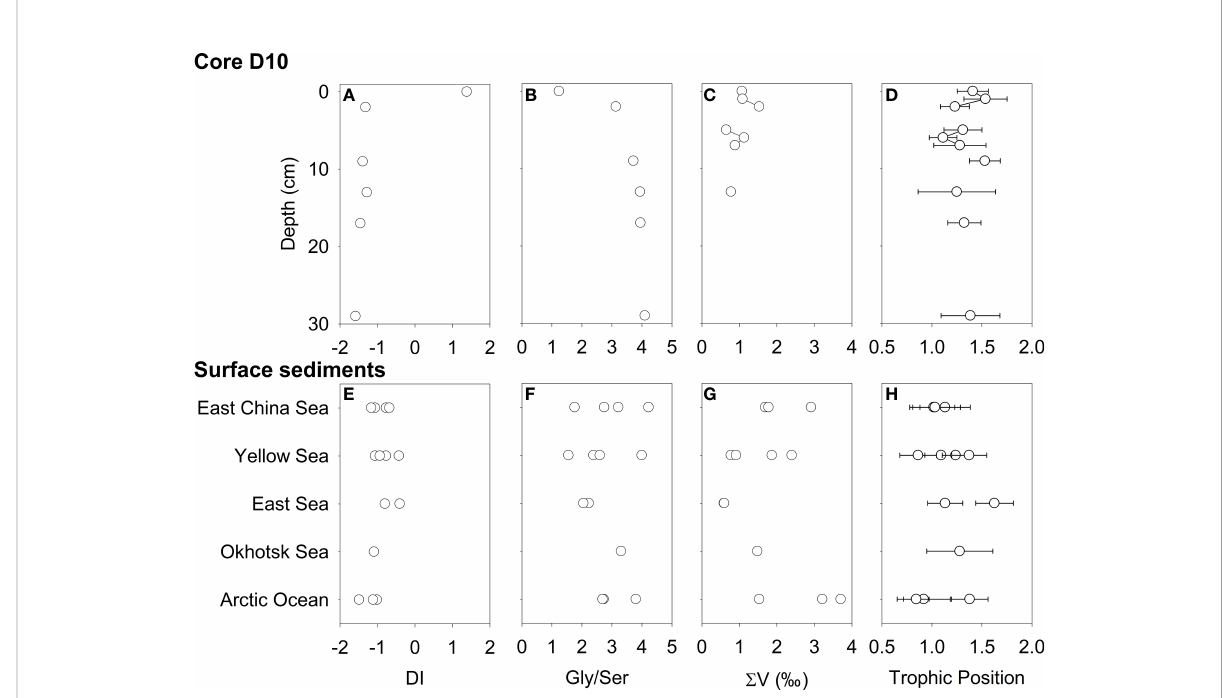
FIGURE 6 Degradation index (A, E) , Gly/Ser ratio (B, F) , ∑ V (C, G) , and trophic position (D, H) of core D10 and surface